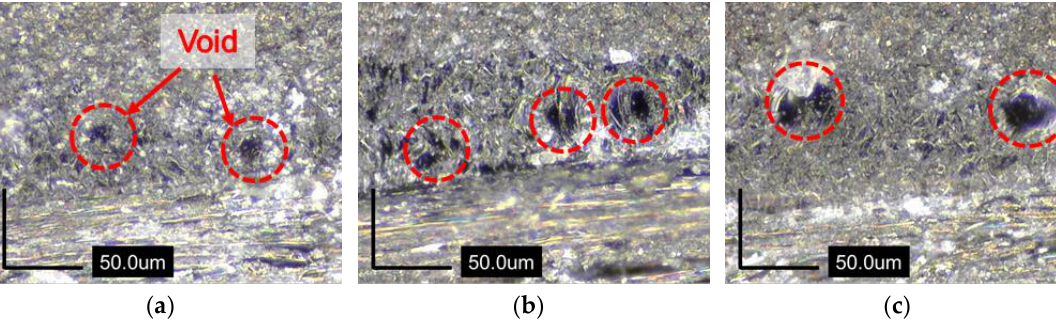
Figure 13. Cross section images in the side of specimens: ( a ) 10 plies; ( b ) 15 plies; ( c ) 20 plies.